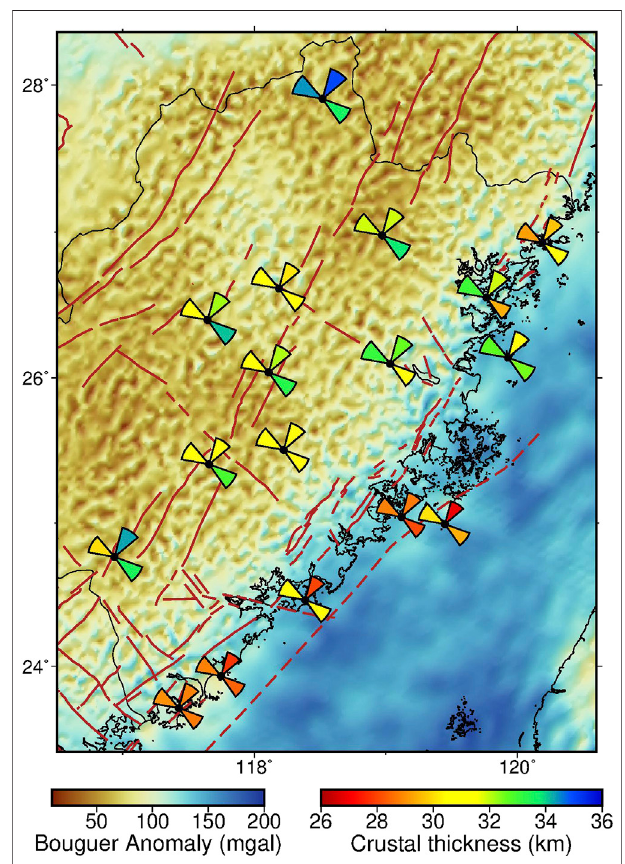
FIGURE 4 | Variation of crustal thickness between the stations estimated by the H-V stacking over the background Bouguer gravity anomaly map. The thickness resulting from the three backzimuth quadrants is shown bycoloredsectorswiththeradiusalsoproportionaltothecorresponding